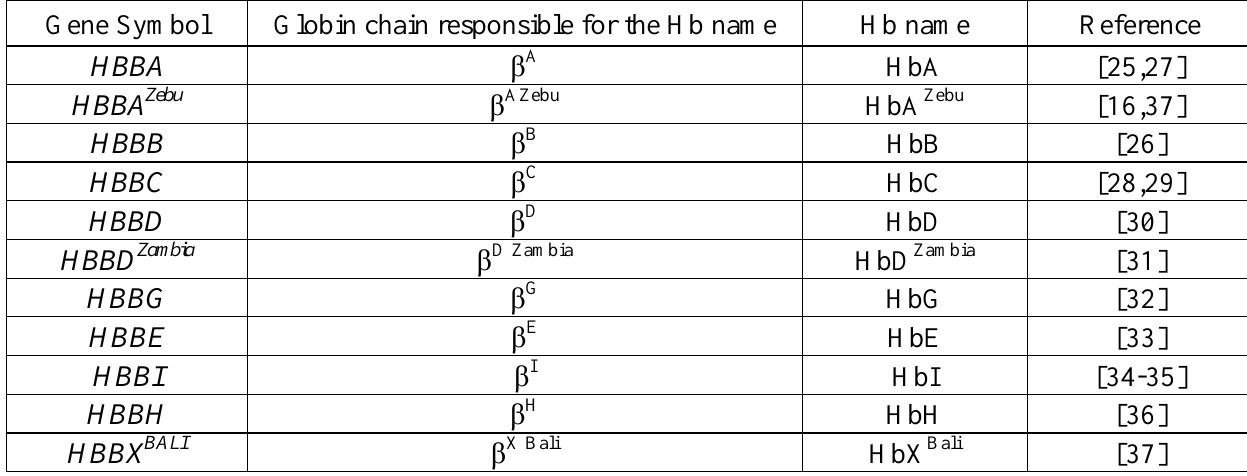
Table 2. Nomenclature of beta globin genes and products in